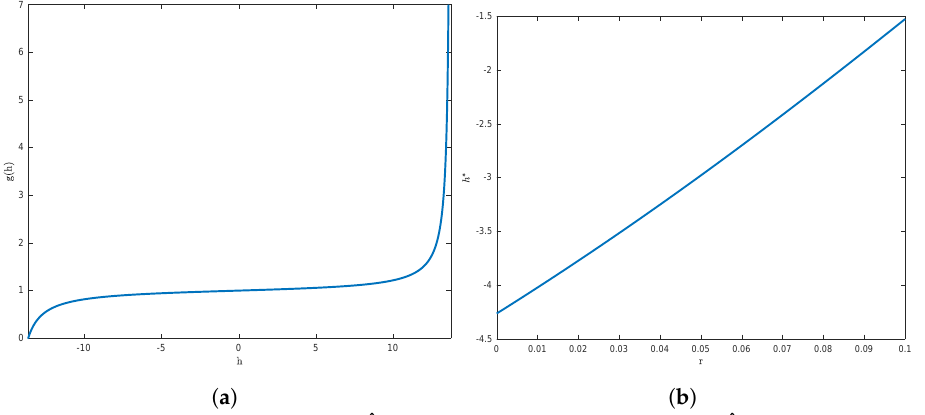
Figure 5. VG model with ˆ µ = 0.0848, ˆ δ = − 0.0577, ˆ σ = 1.0295, ˆ α = 0.8845, ˆ θ = 0.9378, h 1 = − 13.6511, r − µ and h 2 = 14.7399: ( a ) g ( h ) ; ( b ) e α = g ( h )